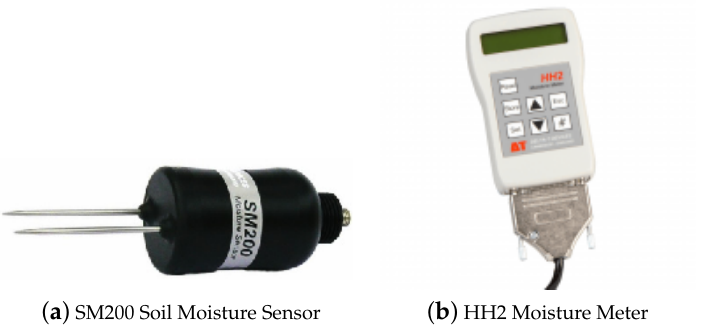
Figure 2. Sensor system for soil moisture level measurement [27]. Reprinted with permission from ref. [27]. Copyright 2019